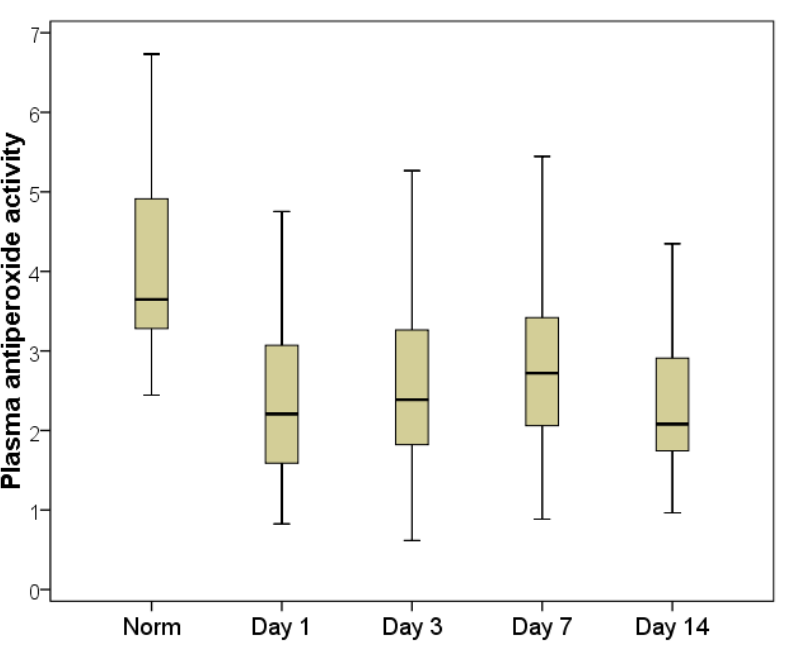
Figure 7. Dynamics of the APA indicator.